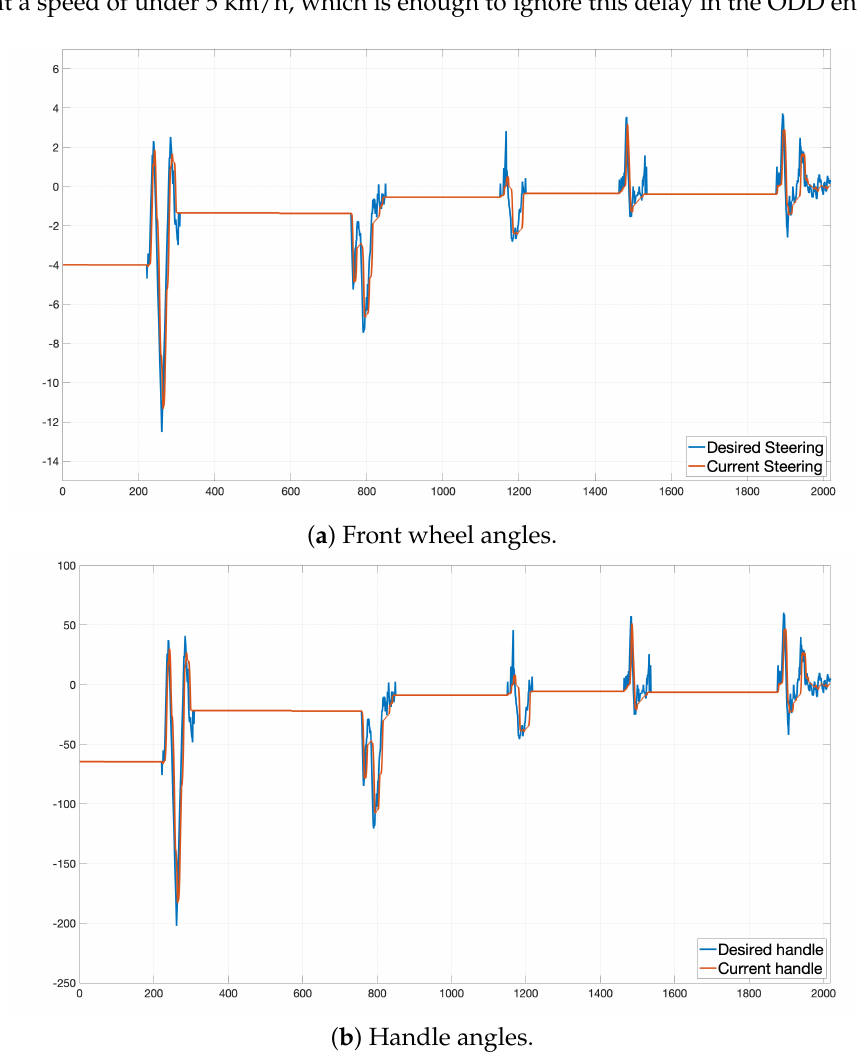
Figure 22. Desired and actual front wheel & handle